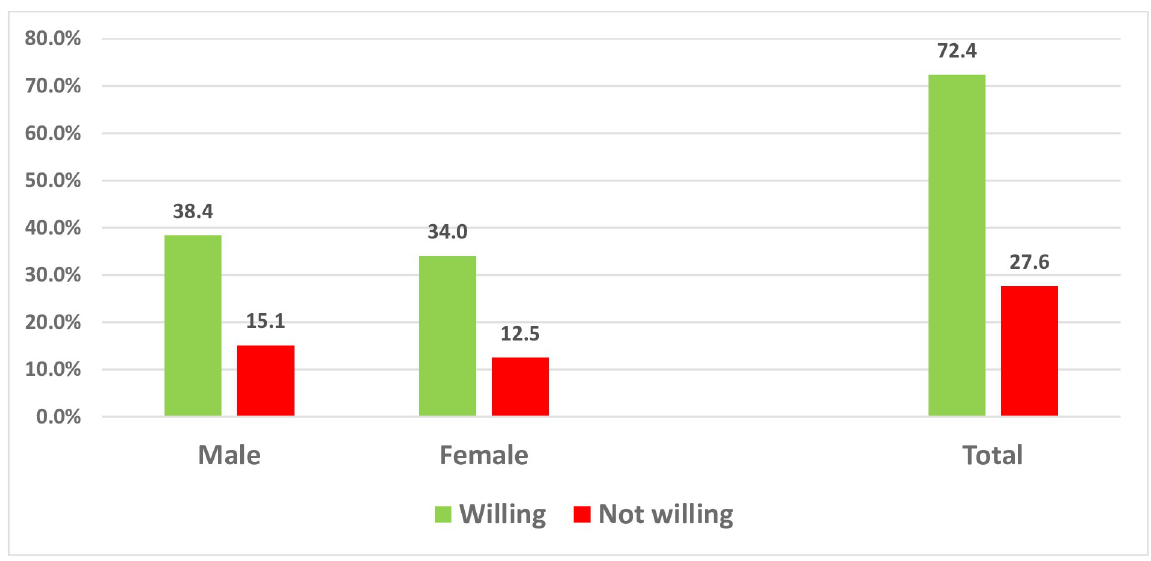
Fig 2. Willingness to accept COVID 19 vaccine according to